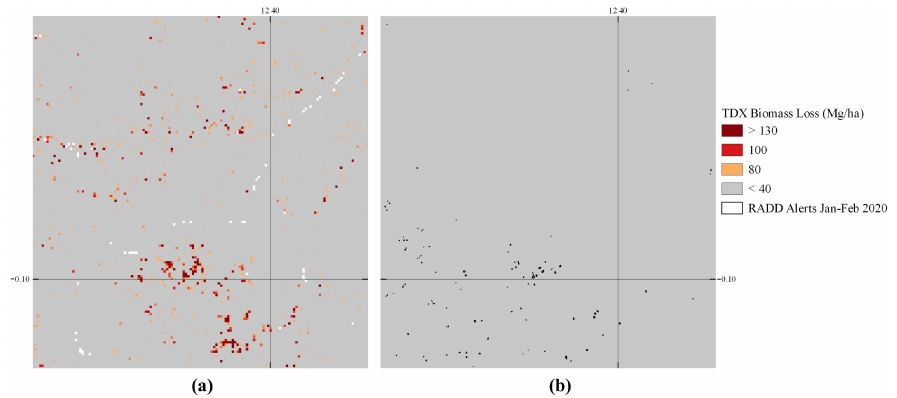
Figure 12. ( a ) Predicted biomass loss from TDX data using the pass selection method (same as Figure 11c). ( b ) Radar for detecting deforestation (RADD) forest disturbance alerts from January and February 2020 over the same area.